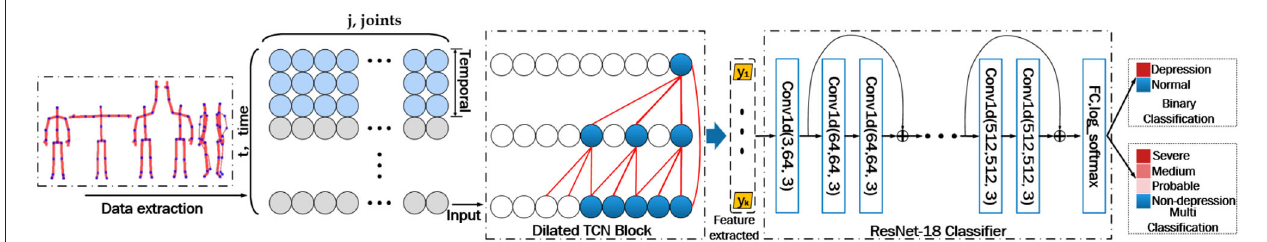
FIGURE 5 | Depression recognition model TCN-ResNet18. The body skeleton for each frame. The d jt -dimensional skeleton vector for time index, constructed by concatenating the 3D and tetrad coordinates of each body joint. The model contains three temporal blocks and one designed residual-18 layers network. The model will be applied to binary and multi depression prediction. In order to match the output dimension of the TCN block, we rebuilt the ResNet18 in single-dimensional convolution architecture in the ResNet-18